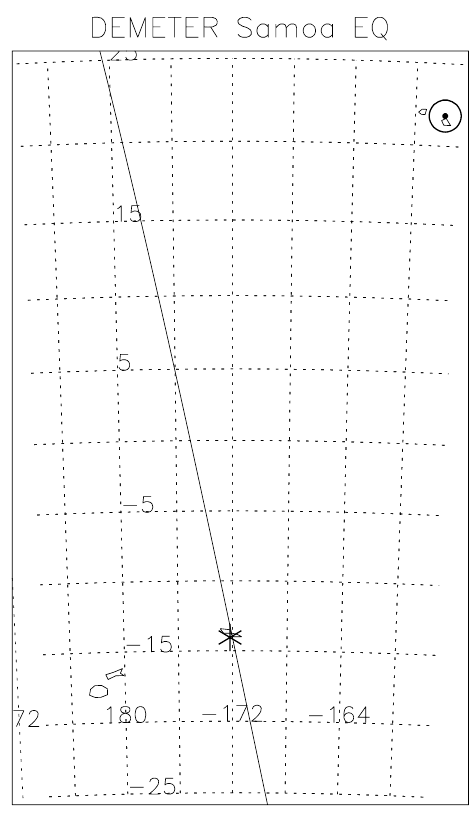
Fig. 1. Locations of the earthquake epicenter (*), of the VLF trans- mitter NPM (circle around a dot) and of one DEMETER orbit on 25 September 2009 (4days before the